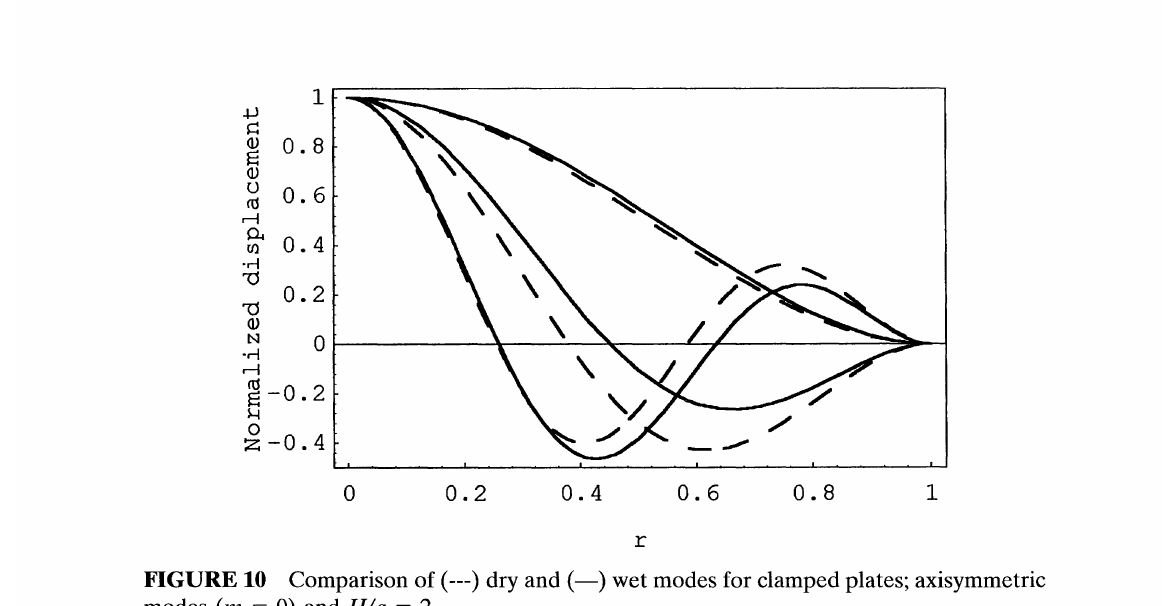
FIGURE 10 Comparison of (---) dry and (-) wet modes for clamped plates; axisymmetric modes (m = 0) and H/a =